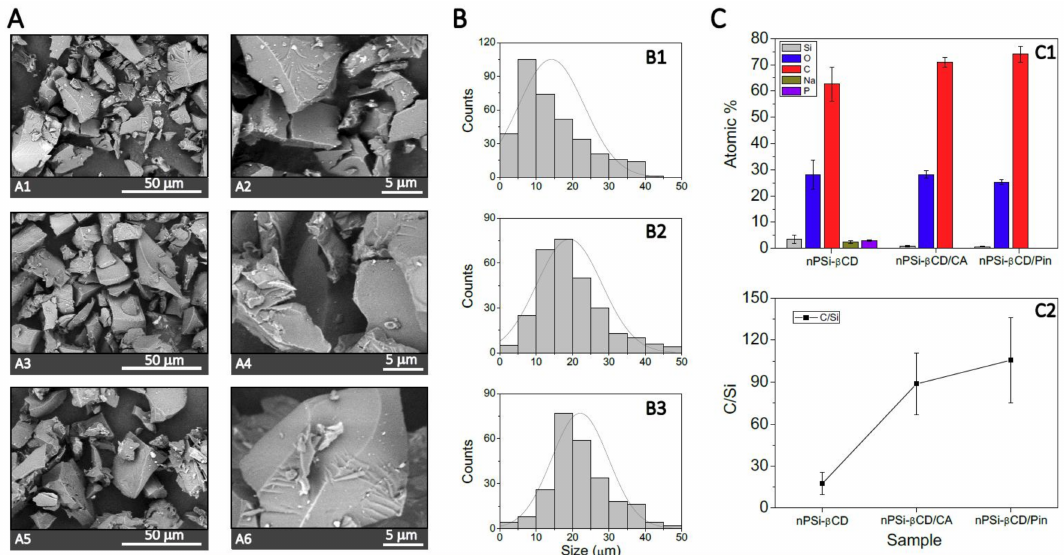
Figure 5. ( A ) Scanning electron microscope images (SEM) of nPSi- β CD loading with polyphenols: ( A1 , A2 ) for nPSi- β CD, ( A3 , A4 ) for nPSi- β CD / CA, ( A5 , A6 ) for nPSi- β CD / Pin. ( B ) Histograms of particle size distribution: ( B1 ) for nPSi- β CD, ( B2 ) for nPSi- β CD / CA, B3 for nPSi- β CD / Pin. ( C ) Atomic % and C / Si ratio of samples obtained from energy-dispersive X-ray analysis (EDX), ( C1 , C2 ),